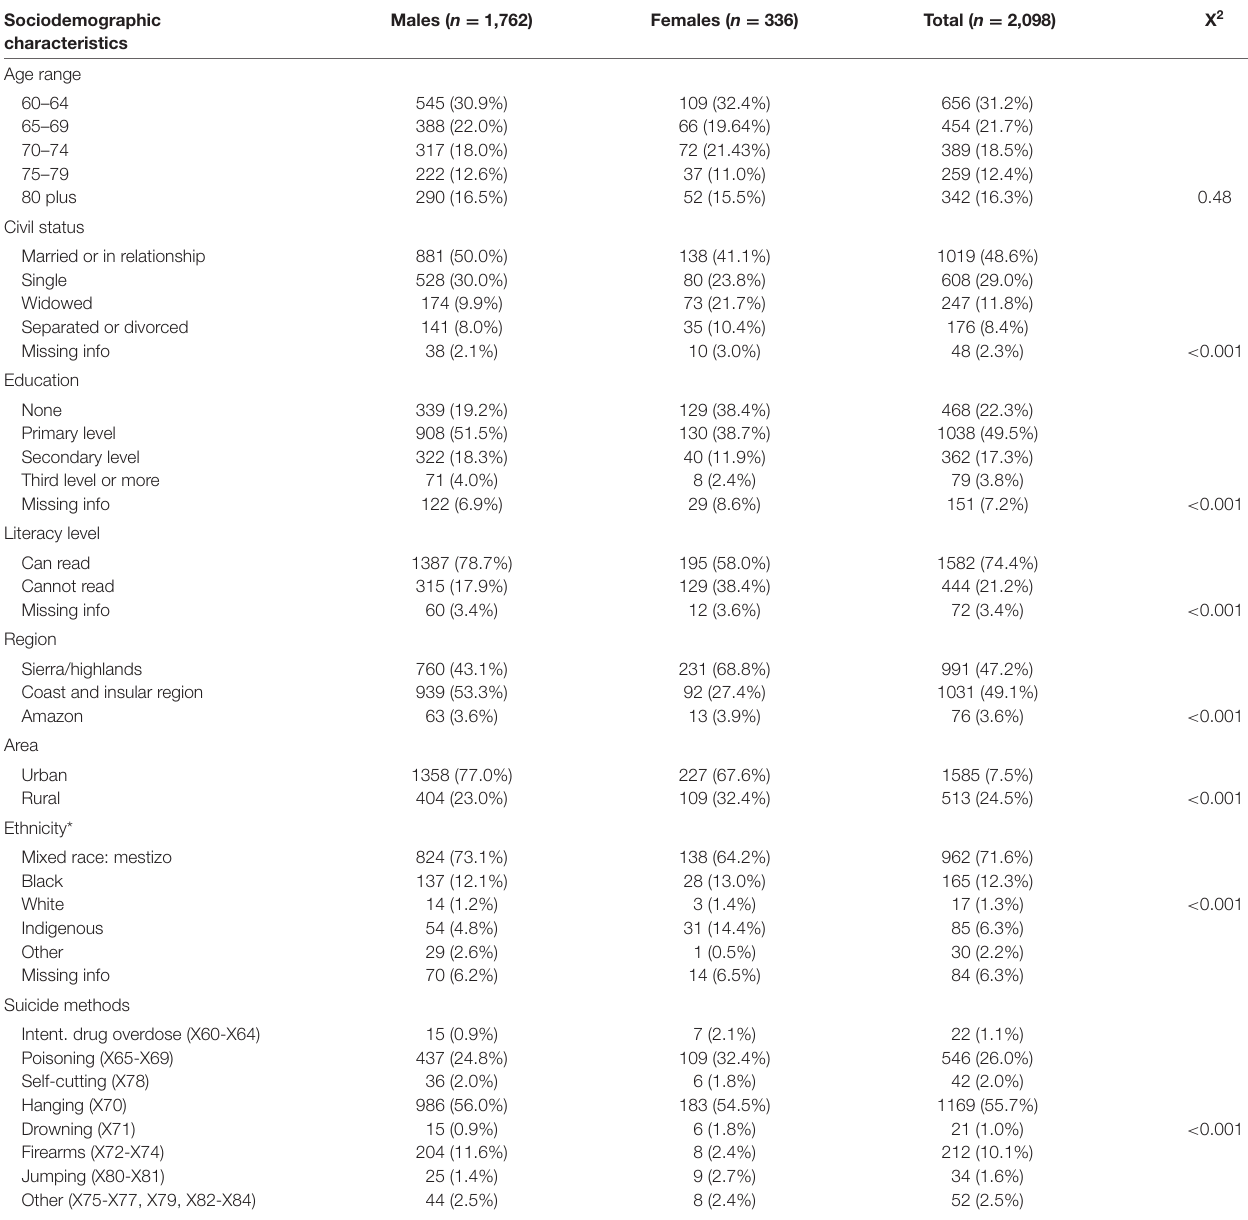
TABLE 1 | Sociodemographic characteristics and methods of the suicide of people who died by suicide by sex. Sociodemographic